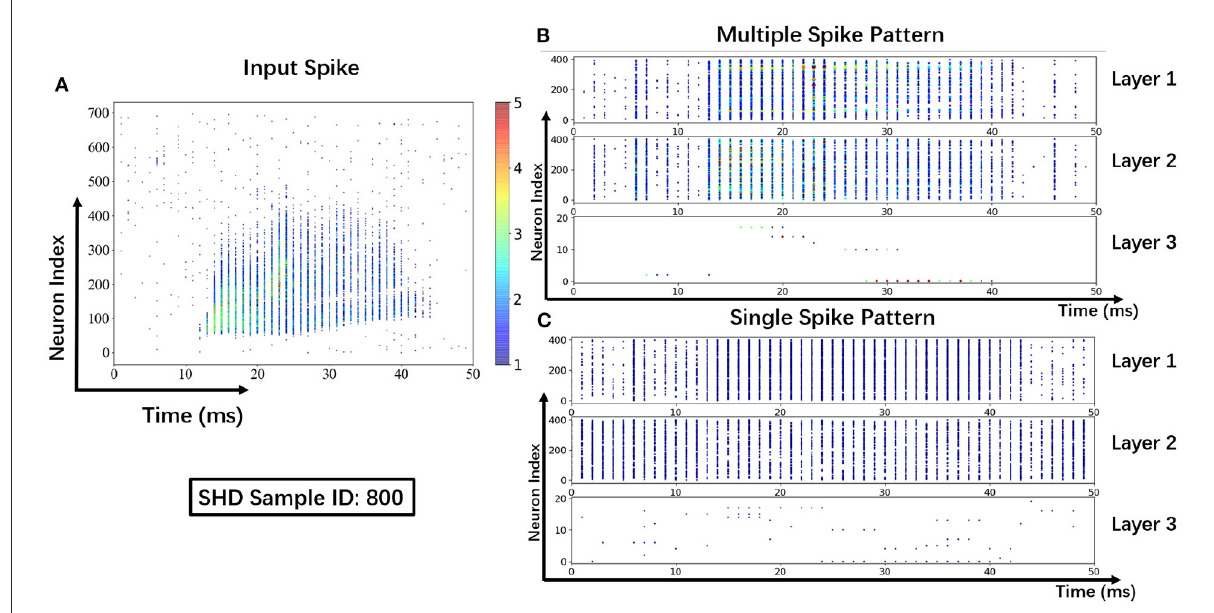
FIGURE8 Spike raster plot: Visualization of spike transmission on SHD sample. (A) Input spikes. (B) Spike transmission in multiple spike pattern. (C) Spike transmission in single spike pattern.